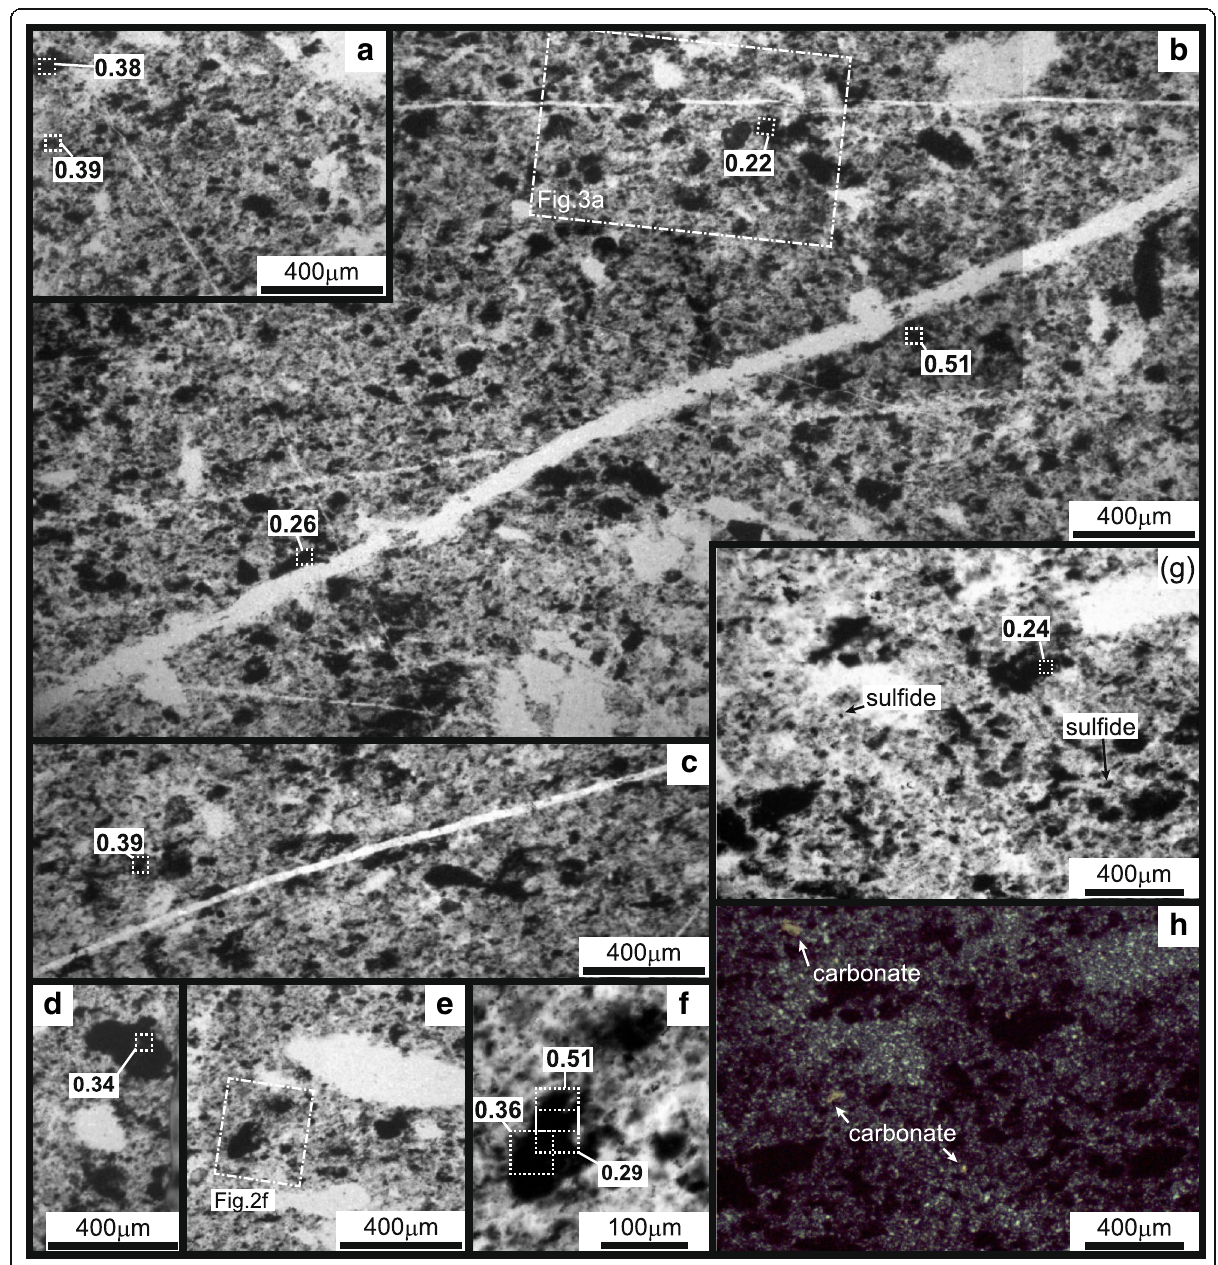
Fig. 2 Optical photomicrographs of the analyzed thin sections. a – g Plane-polarized light photomicrographs of the thin section 96NP452. b Composite image of the photomicrographs; the dashed rectangle in b corresponds to the area shown in Fig. 3a. f Enlarged view of the dashed rectangle in e . h Cross-polarized light photomicrograph of the same area in g . i , j Plane-polarized light photomicrographs of the thin section T-58. i Composite image of the photomicrographs. j Enlarged view of the dashed rectangle in i . The locations (50 × 50 μ m 2 dotted squares) of the 12 clots with satisfactory signal/noise ratios and their calculated R 3/2 ratios (1024 scans) are shown in a – d , f , g ,